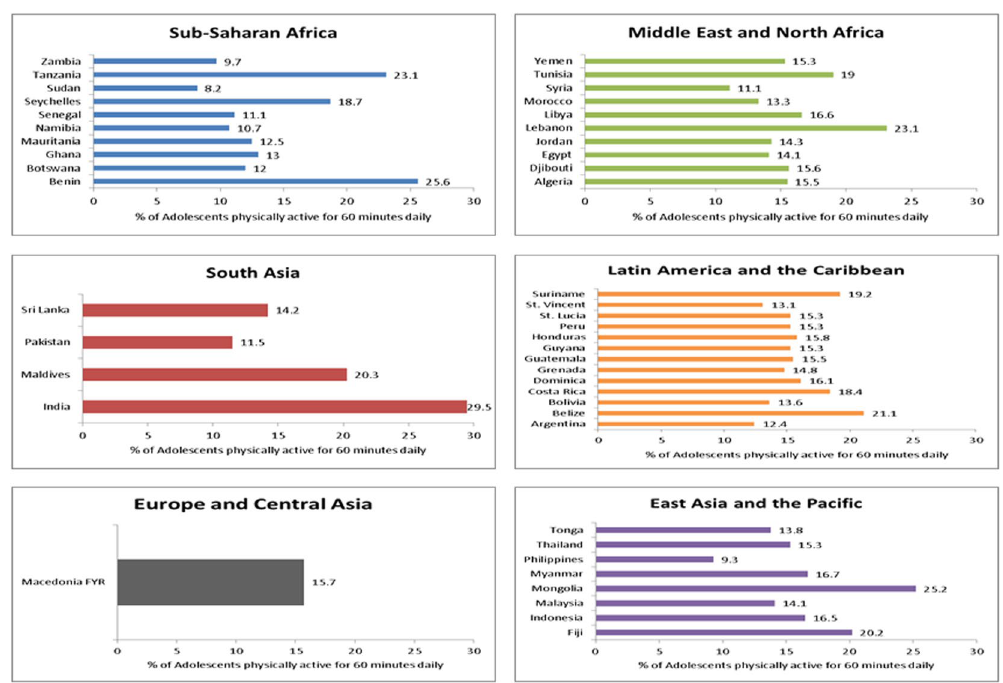
Figure 3. Percentage of adolescents meeting the daily PA recommendations in LMICs grouped by World Bank